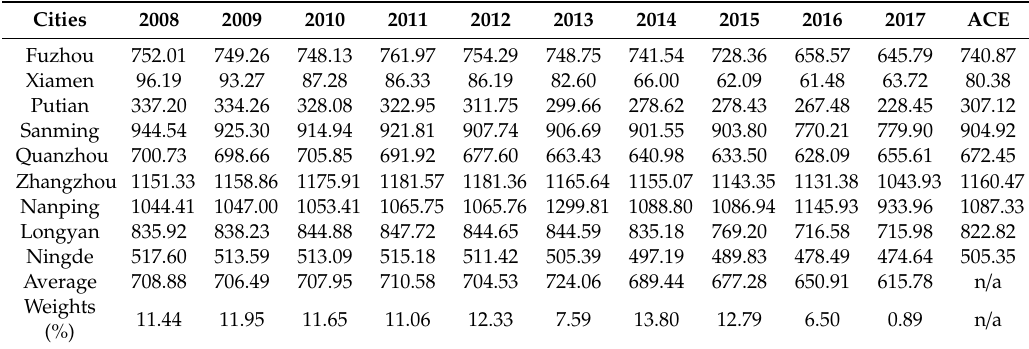
Table 2. Average agricultural carbon emissions (ACE) in Fujian (units: 10 3 tonnes of carbon).